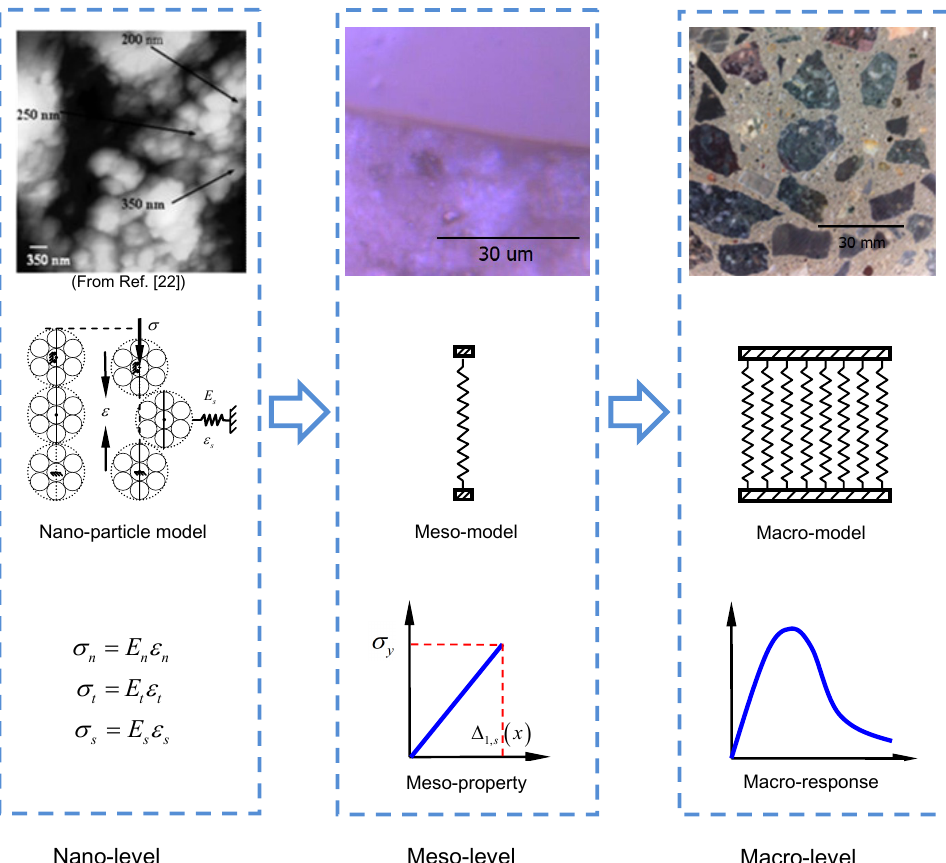
Figure 5. Concrete modeling at the nano-, meso- and macro-scales.